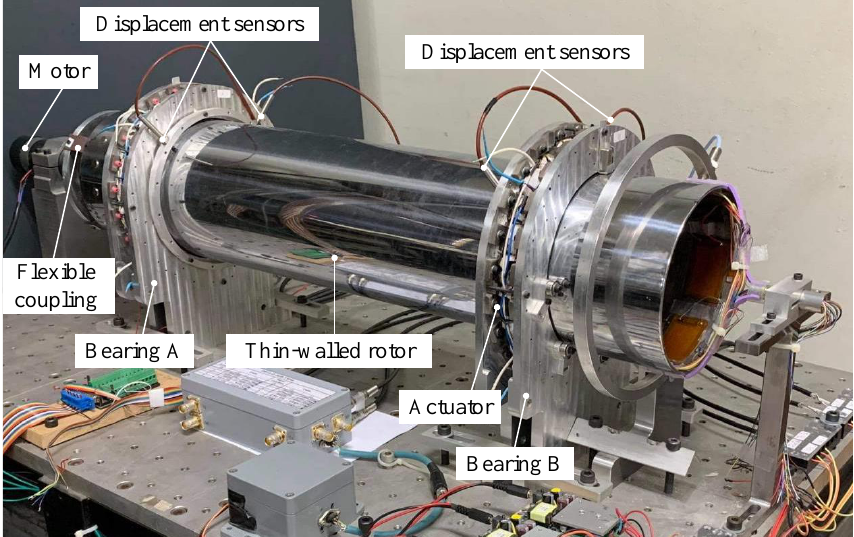
Figure 5. Experimental thin-walled rotor with two radial DAMBs.